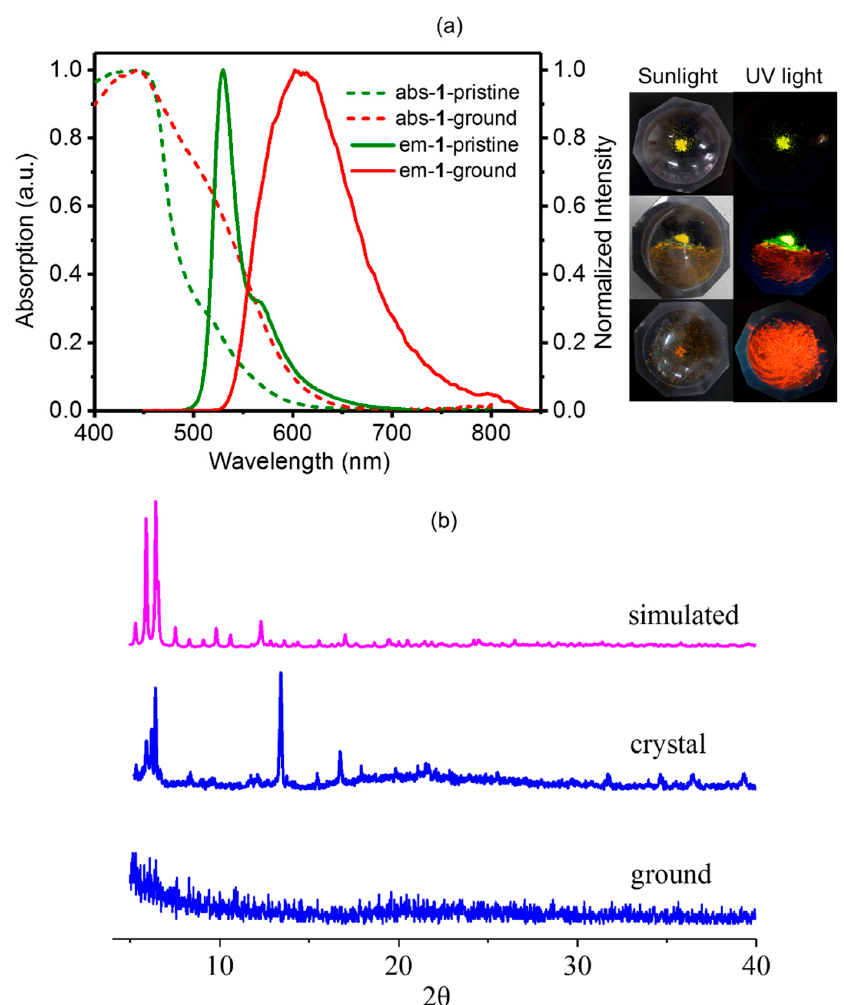
Figure 4. ( a ) The normalized UV-Vis absorption and emission spectra together with the images of Au 4 Ag 4 cluster complex 1 under ambient light and UV irradiation (365 nm) before and after mechanical grinding. ( b ) The simulated and measured X-ray diffraction patterns of Au 4 Ag 4 cluster complex 1 before and after mechanical grinding.